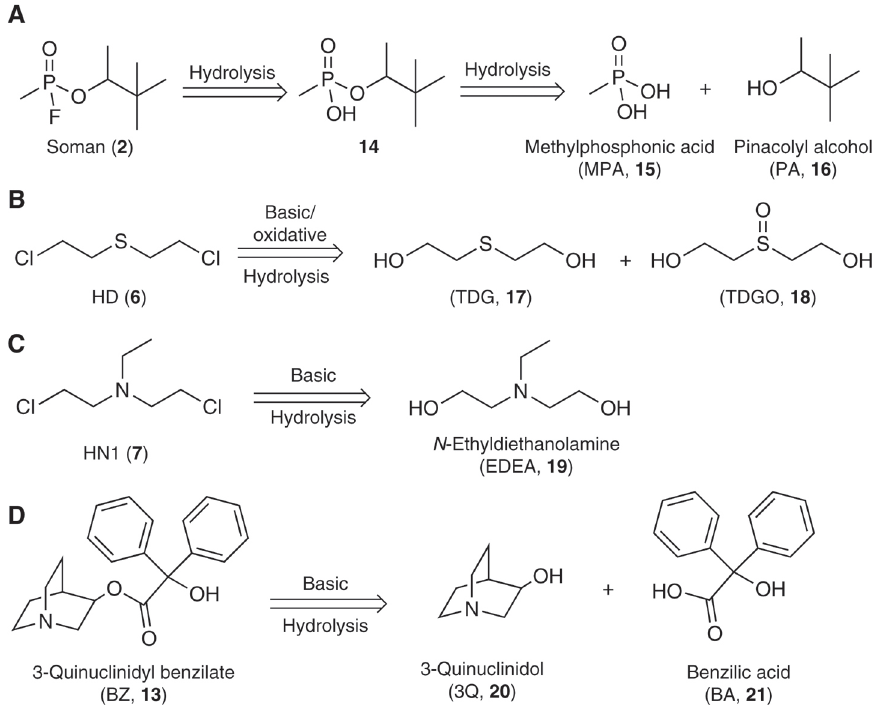
Figure 2: Hydrolysis products for selected CWAs and their structures. These products can be used retrospectively as forensic markers in the identification of the original